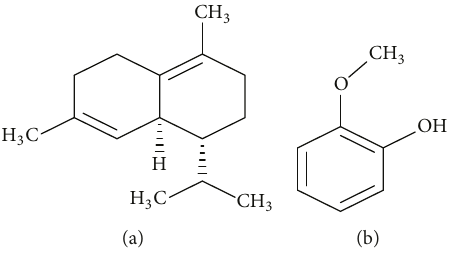
Figure 9: The main structures of Juniperus oxycedrus L.